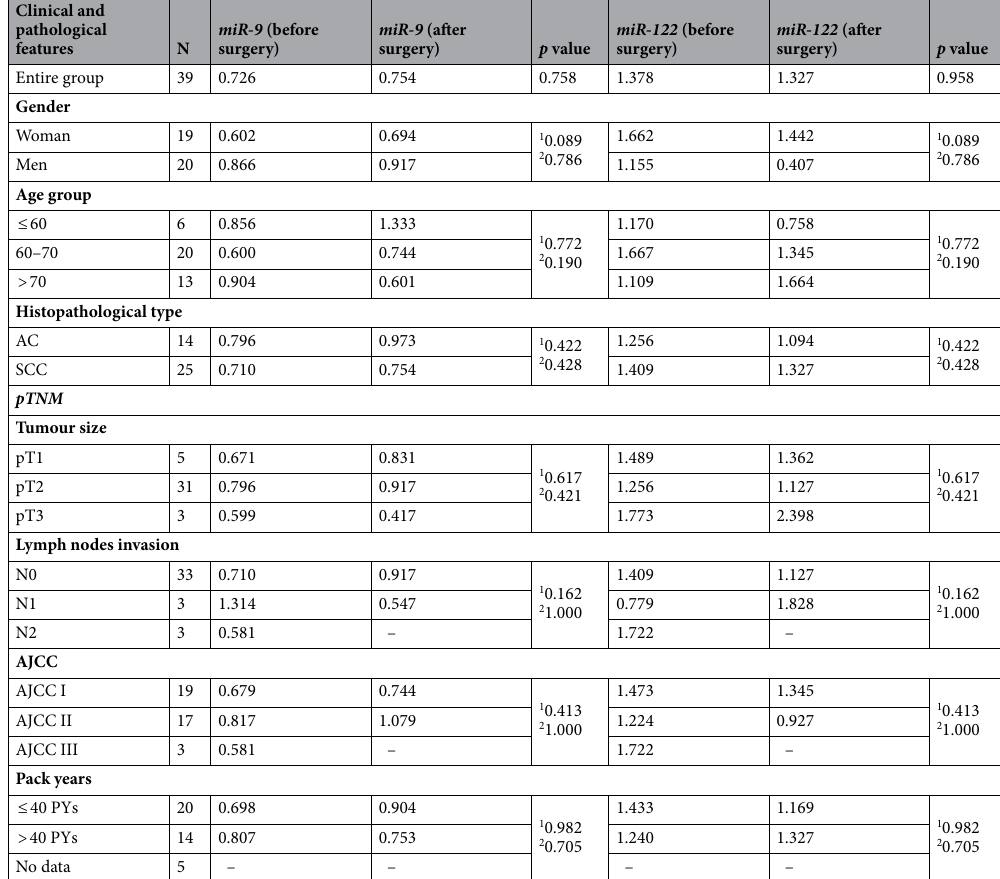
Table 2. Clinical and pathological features: median expression level (RQ value) of evaluated microRNA. 1 pertain to expression before surgical treatment, 2 pertain to expression after